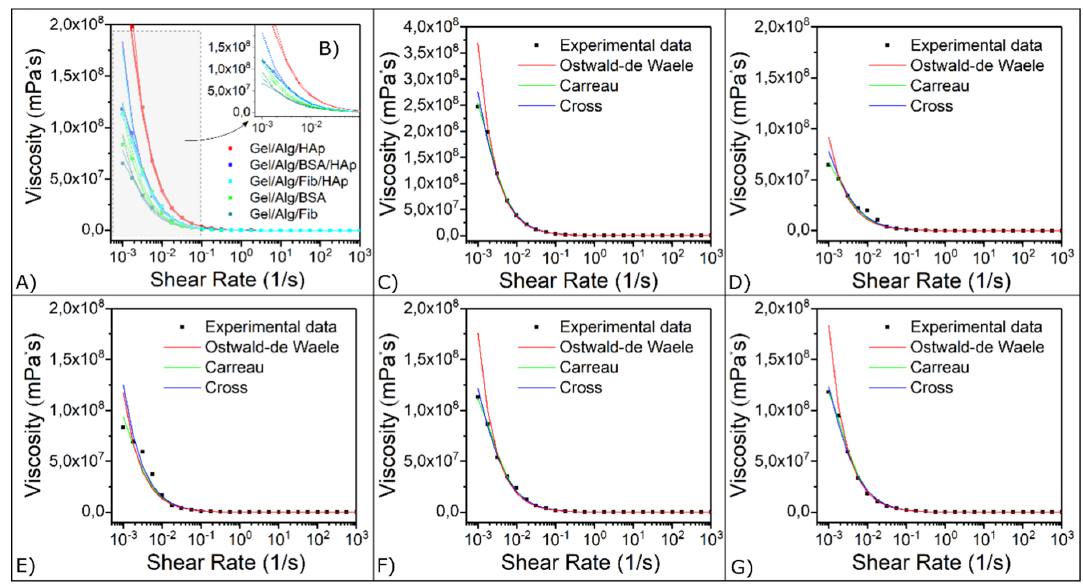
Figure 6. Fitting results. ( A ) Experimental and obtained data for the five studied samples. ( B ) Close up. ( C ) Gel/Alg/HAp. ( D ) Gel/Alg/Fib. ( E ) Gel/Alg/BSA. ( F ) Gel/Alg/Fib/HAp. ( G ) Gel/Alg/BSA/HAp.